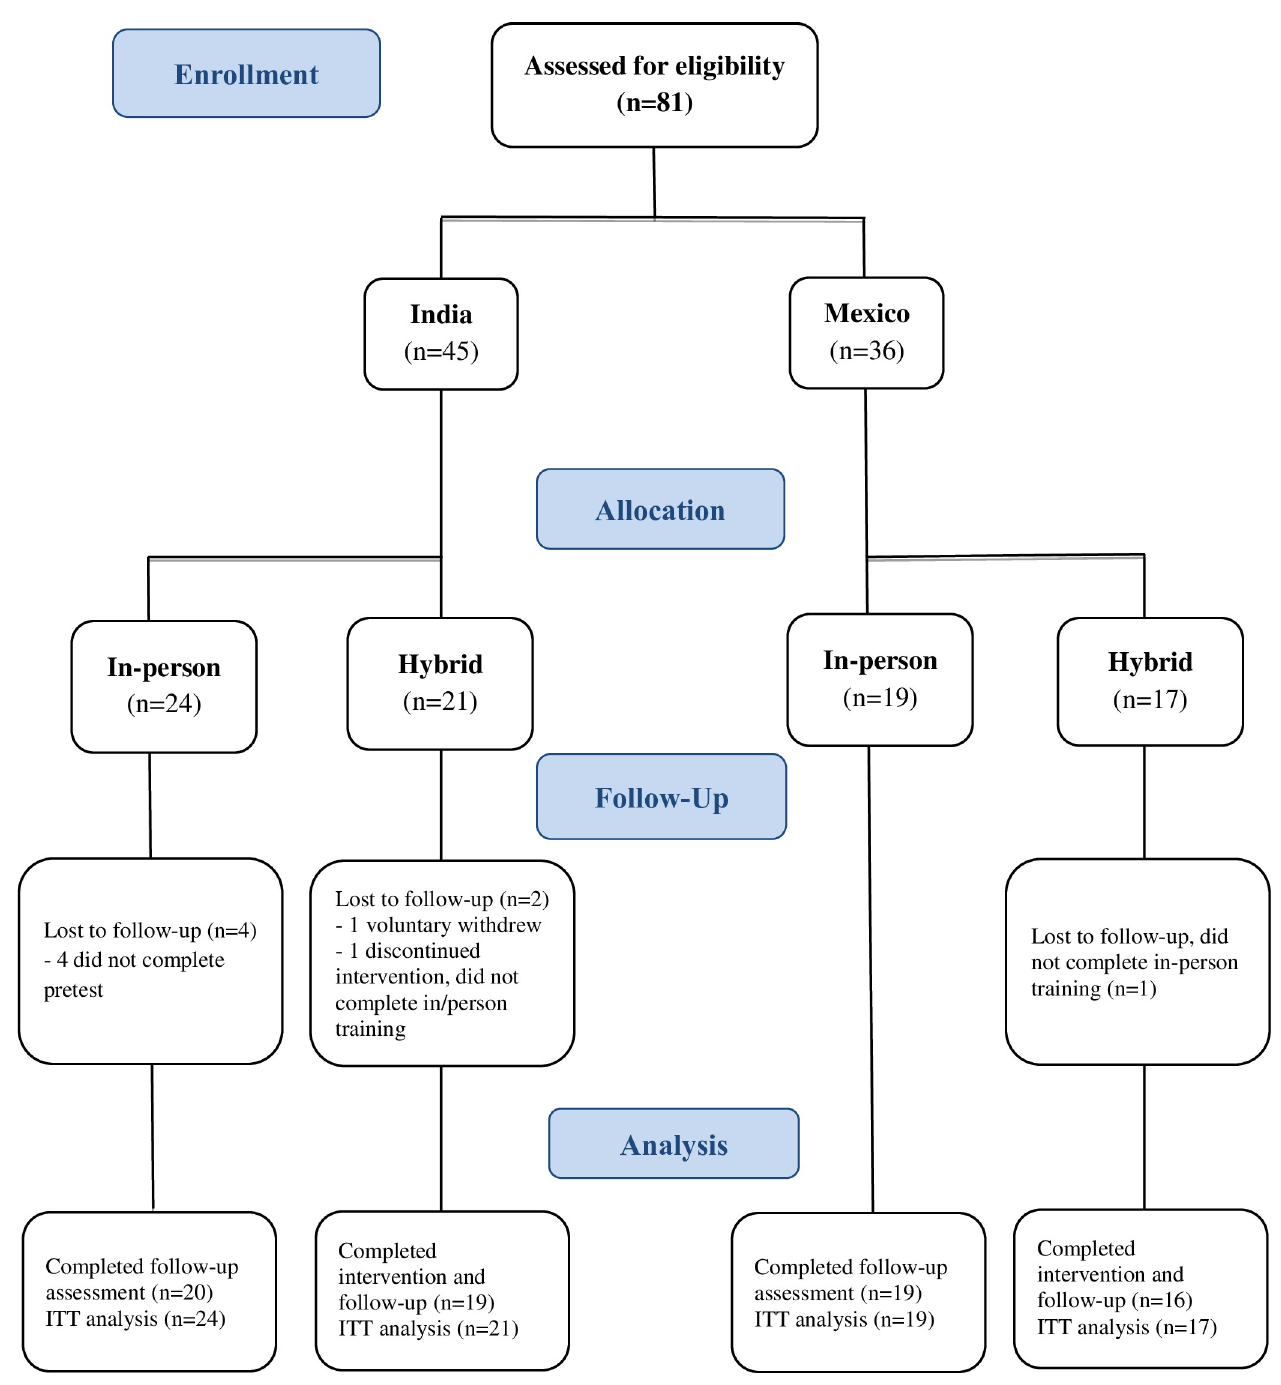
Fig 1. Flow chart of study